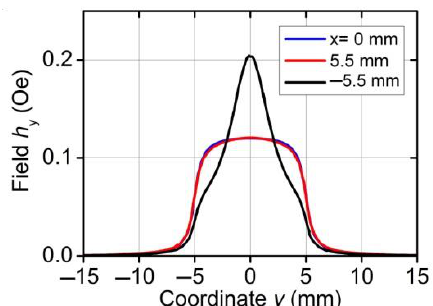
Figure 4. Distribution of the magnetic field h y along the length inside the “magnetic capacitor” for I = 100 mA and z = 0.